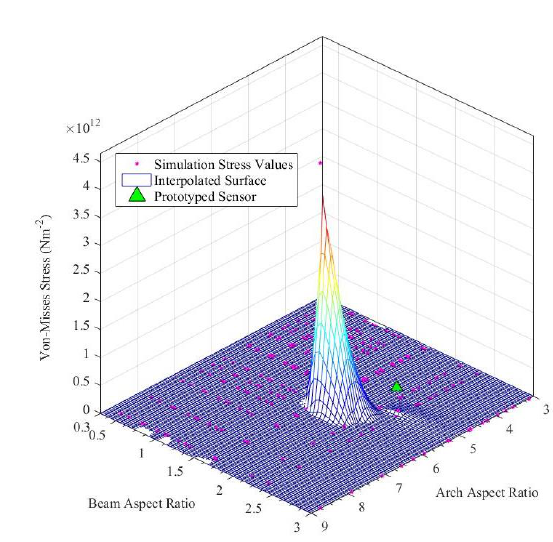
Figure 8. Von-Mises stress vs. structural design parameter study for the cylindrical arch spring.